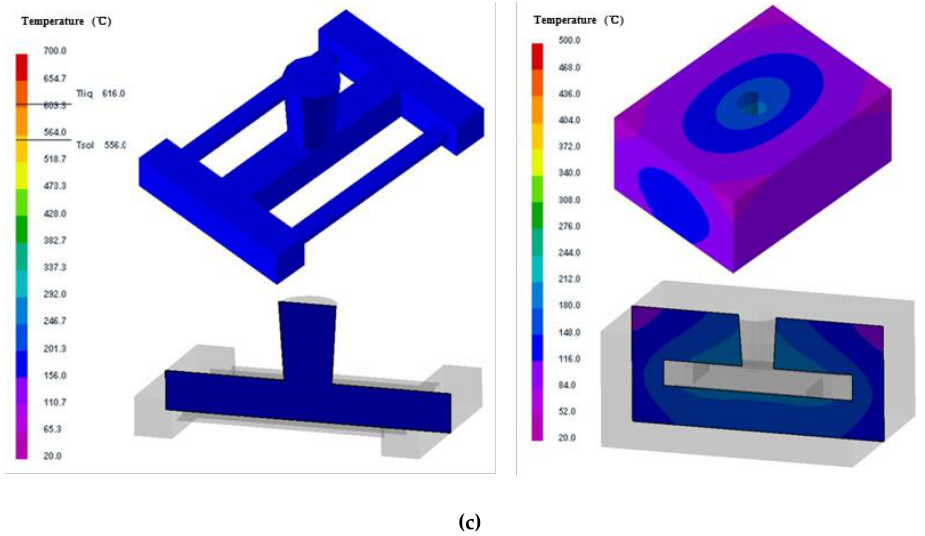
Figure 8. The temperature fields of the traditional sand mold and casting: ( a ) 500 s; ( b ) 1500 s and ( c ) 5600 s.